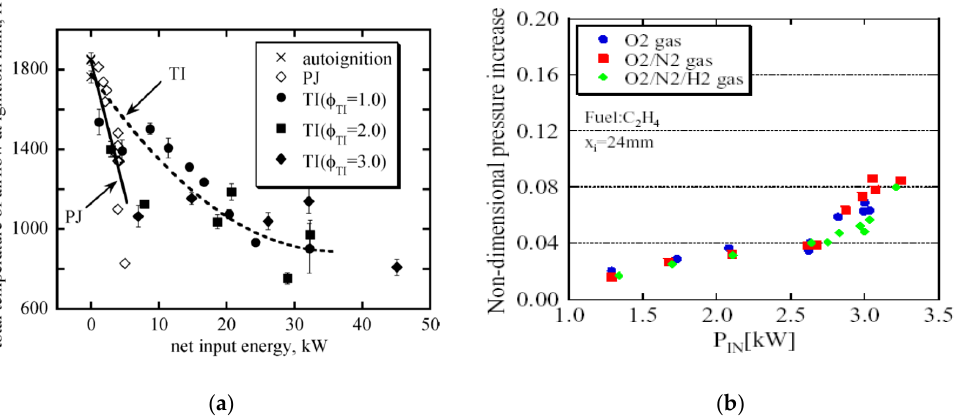
Figure 4. ( a ) Effects of net input energy with residual H 2 combustion heat on the ignition limit for φ = 0.4, [48], reprinted from [48] with permission from AIAA; ( b ) pressure effect of the plasma torch depending on plasma power (the figure is courtesy of Dr. K. Takita).